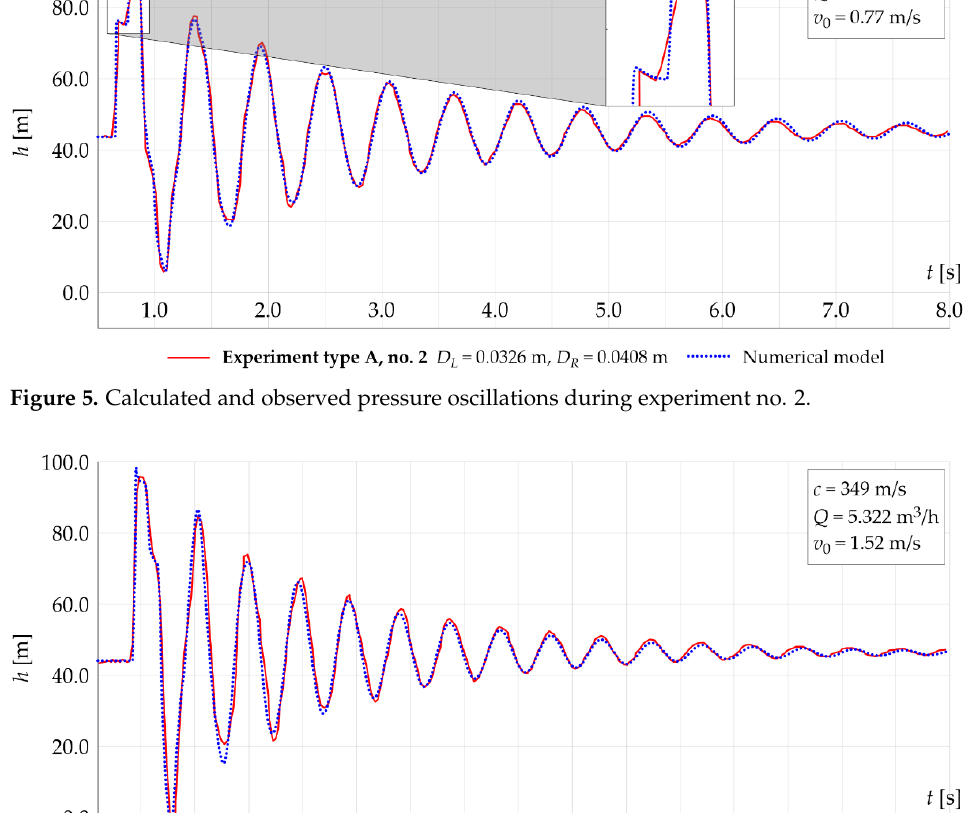
Figure 7. Calculated and observed pressure oscillations during experiment no. 4.